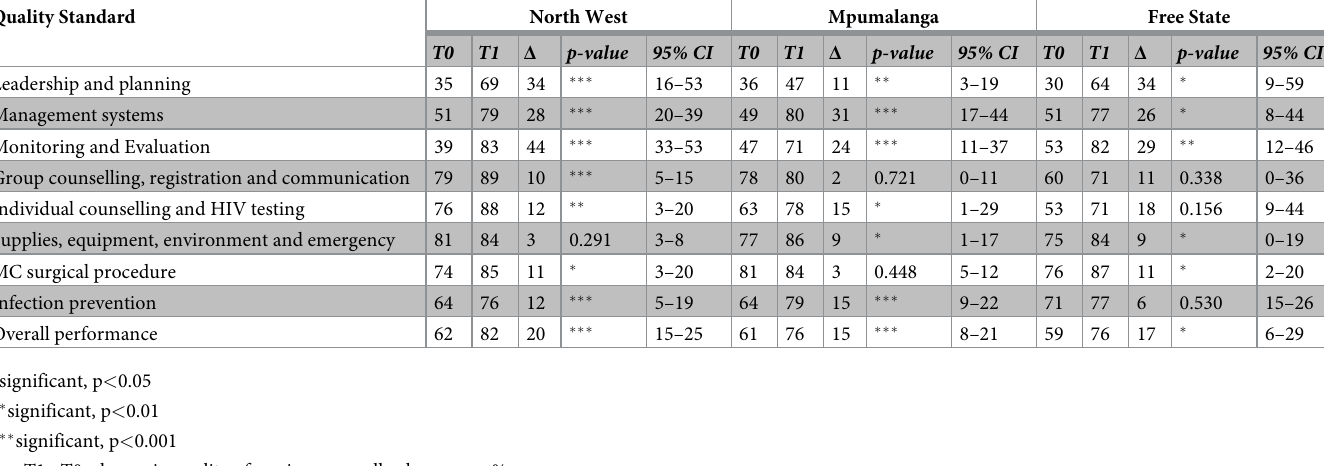
Table 3. Paired samples t-test (2-tailed) comparing the change in quality of service mean scores before and after CQI support intervention by